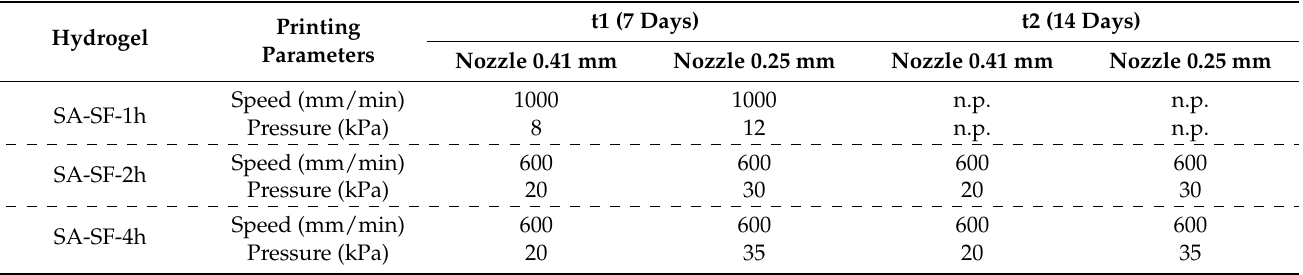
Figure 3. Printability assessment of the SA-SF hydrogels. ( A ) extrusion of the material using the 3D printer to set an adequate pressure value; ( B ) hydrogel appearance after printing; ( C ) and ( D ) examples of SA-SF hydrogel printed in serpentine structure and grid structure forms, respectively. Table 5. Optimized values of printing parameters (n.p. =